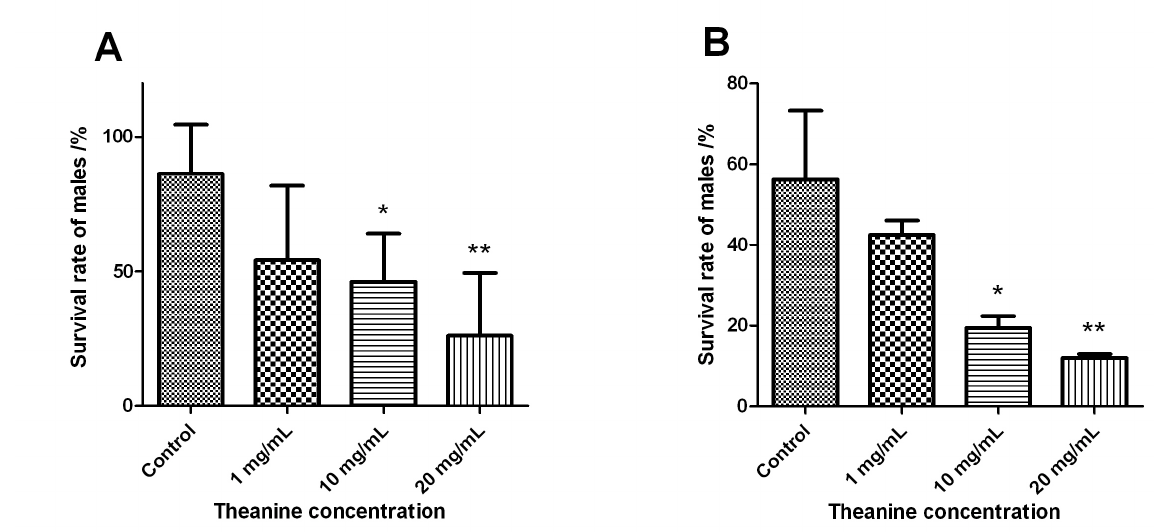
Figure 4. Reduced starvation tolerance of male flies fed with L -theanine. Survival rate of males after wet (A) and dry (B) starvation, * p < 0.05 versus control, ** p < 0.01 versus control,